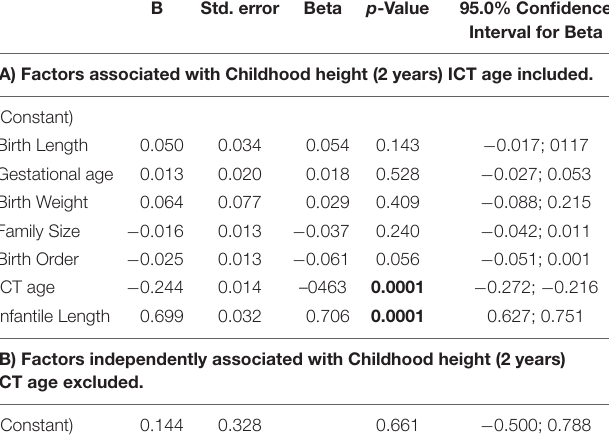
TABLE 4 | Multivariate regression analysis of childhood height SDS. B Std. error Beta p -Value 95.0% Confidence Interval for